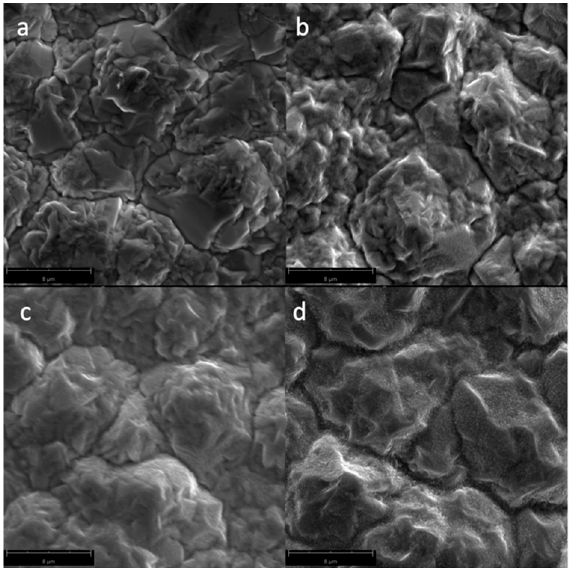
Figure 3. SEM micrographs of the surfaces of the Cu samples (magnified at 10,000×) subjected to oxygen plasma with varying irradiation times: ( a ) untreated; ( b ) 60 s; ( c ) 180 s; and ( d ) 300 s. Table 2. Model reaction set with the corresponding activation energy of the products.